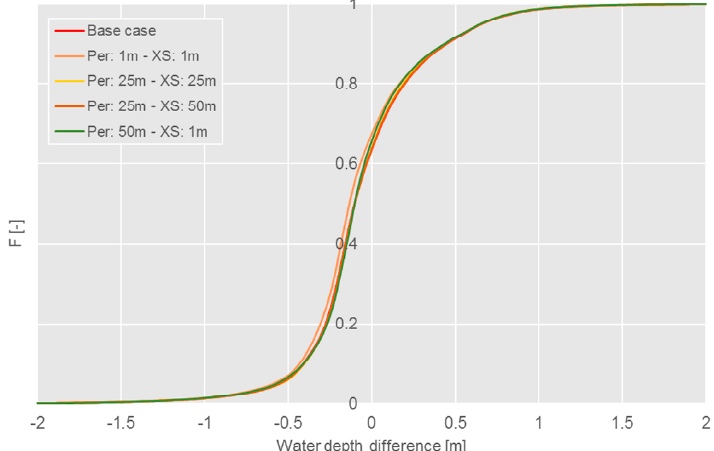
Figure 7. Sensitivity of RAPIDE results to the discretization resolution of the flood perimeter and the auxiliary lines (‘Per’ and ‘XS’ in the legend, respectively). Cumulative density functions of ∆ WD for the different resolutions considered.